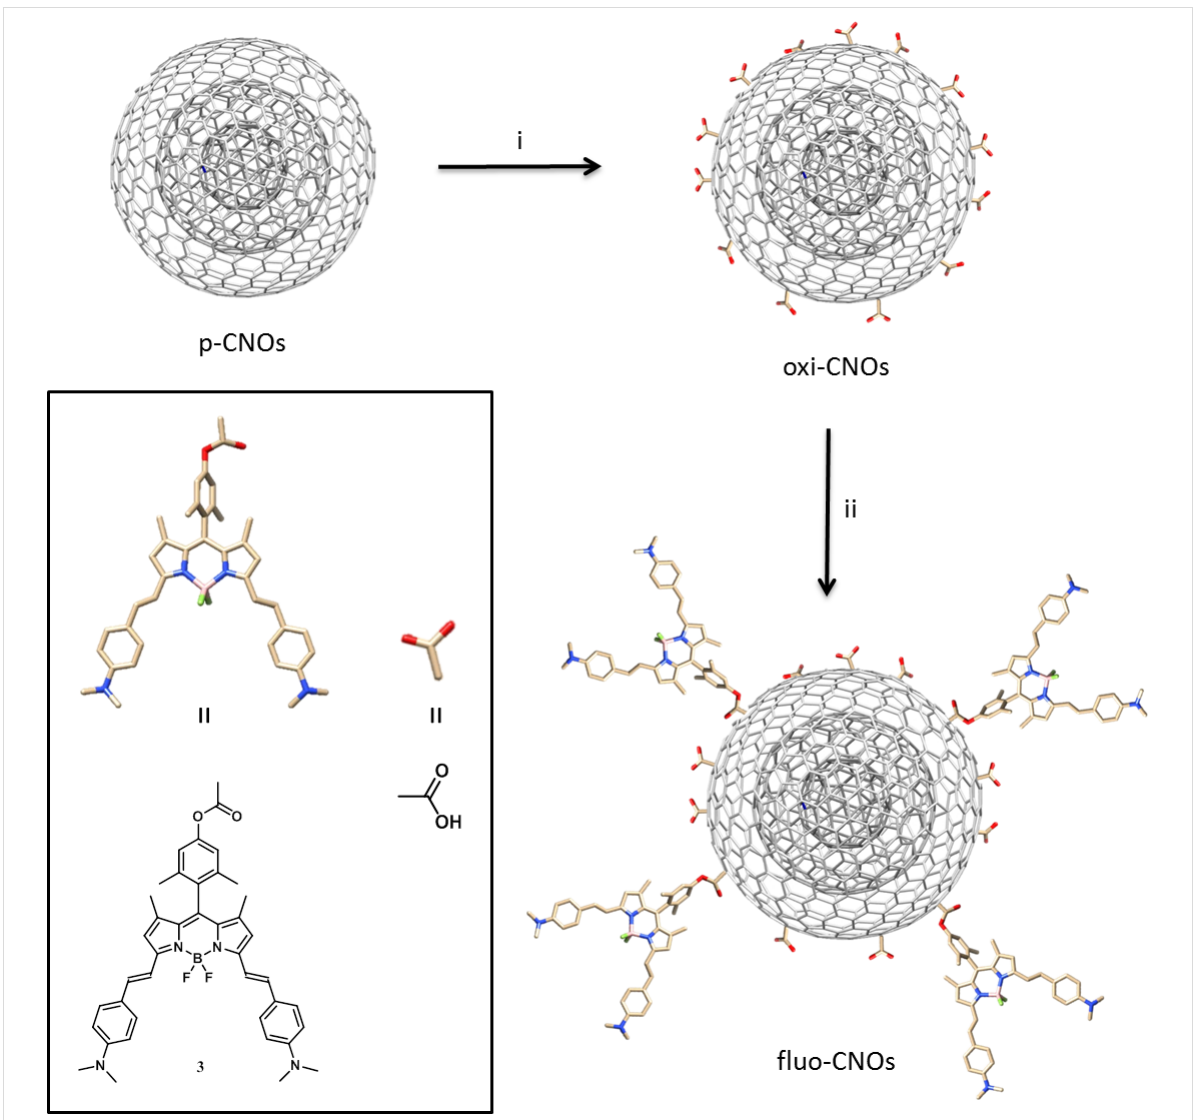
Scheme 2: Procedure for the preparation of carboxy-functionalized oxi-CNO and fluorescently labelled fluo-CNO. i) Nitric acid, reflux, 48 h; ii) EDC, NHS, DMAP, 3 , dry DMF, N 2 , RT, 20 h.